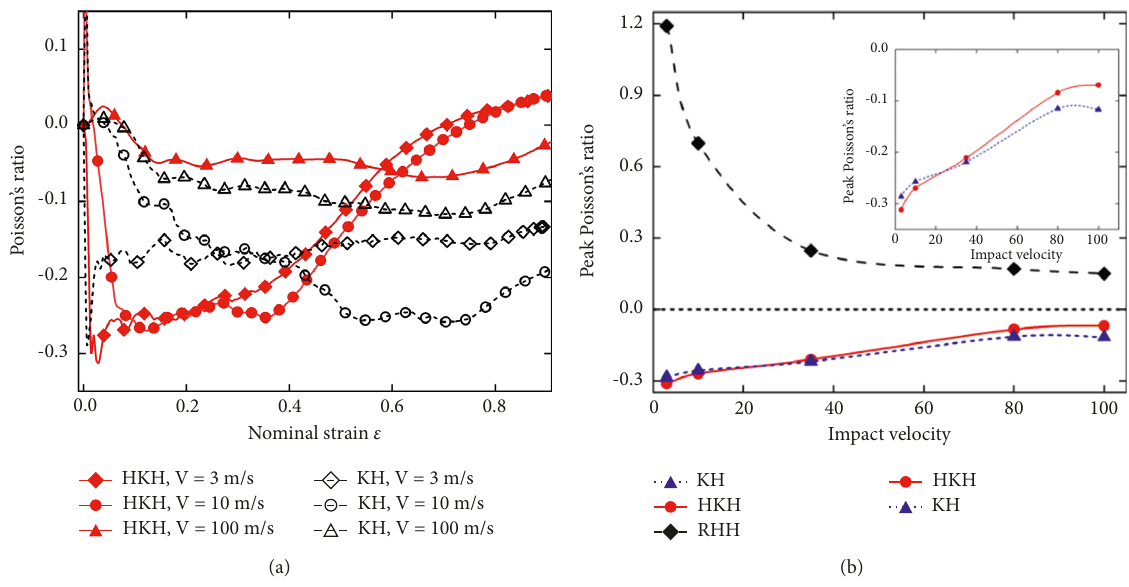
Figure 14: Map of dynamic Poisson’s ratio: (a) dynamic Poisson’s ratio-stain curve of the HKH and KH with different impact velocities and (b) peak Poisson’s ratio of three honeycombs with different impact